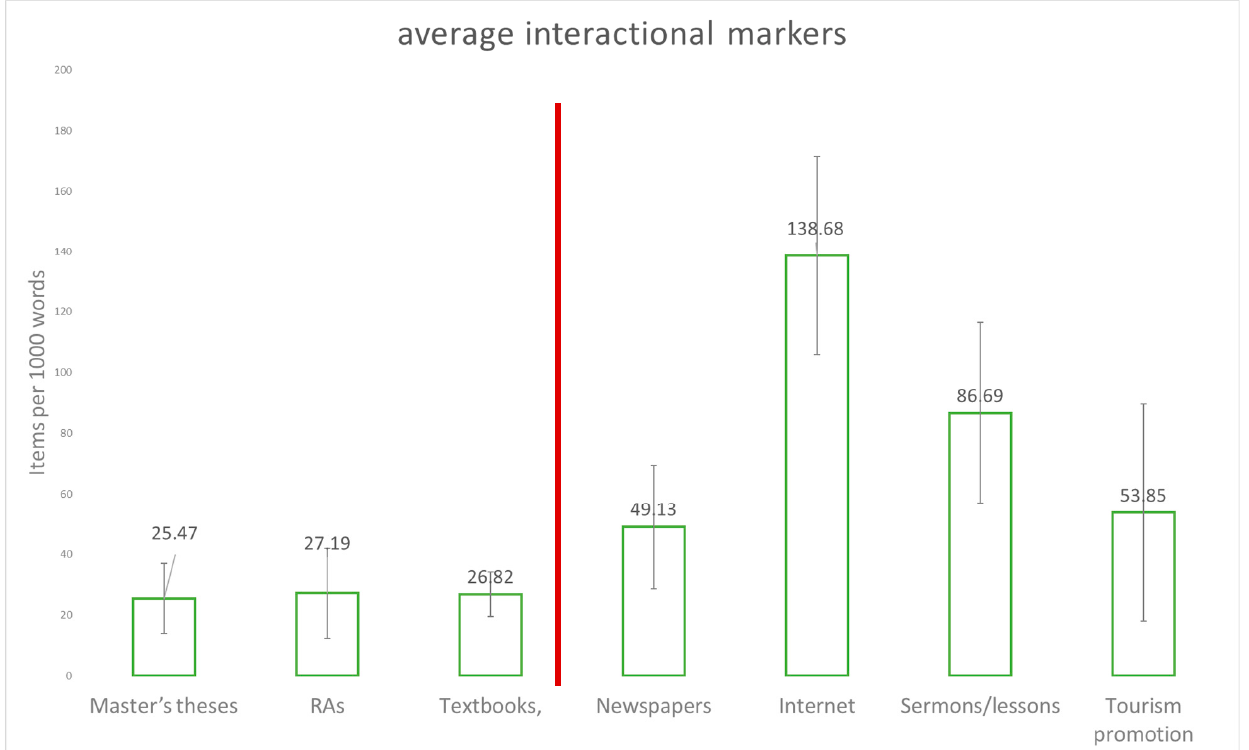
Figure 7. Interactional markers. Items per 1000 words (on average).